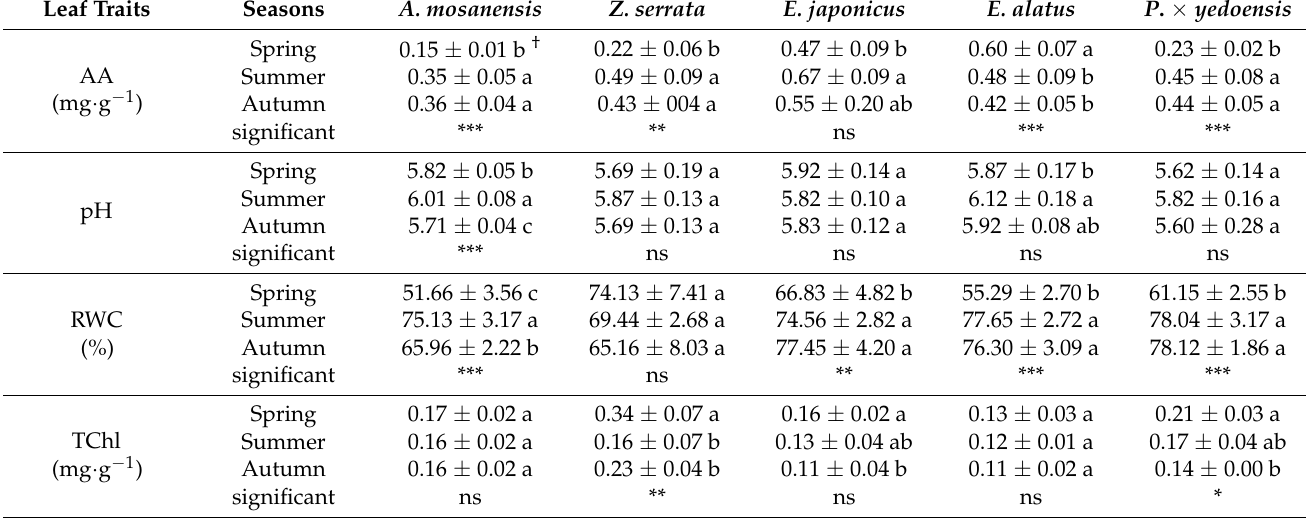
Table 3. Average leaf trait parameter values of five plant species in three seasons (spring, summer and